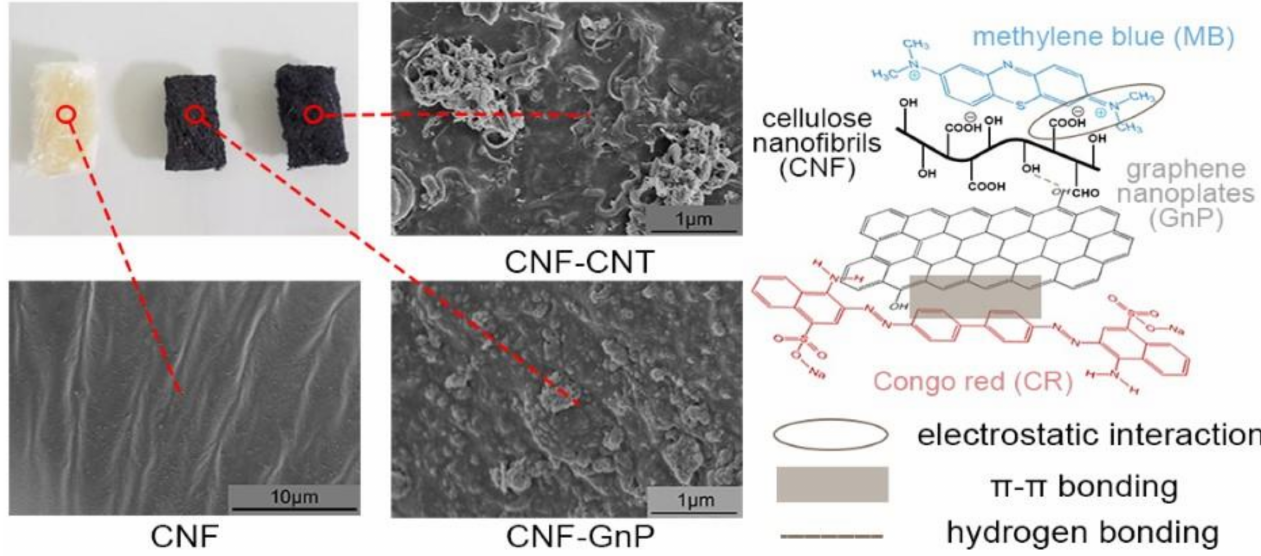
Figure 5. Cellulose nanofibers (CNF) and carbon nanotubes (CNT) or graphene nanoplate (GnP) hybrid aerogels for the adsorption and removal of cationic and anionic organic dyes [126], ©MDPI,